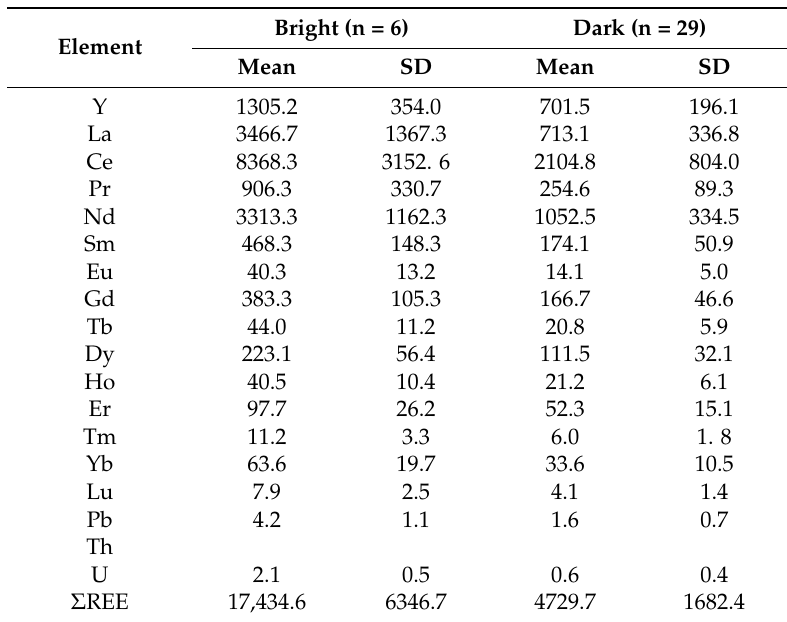
Table 7. LA-ICP-MS data (ppm) for bright and dark apatites from Chadormalu MAV-inner ore apatite